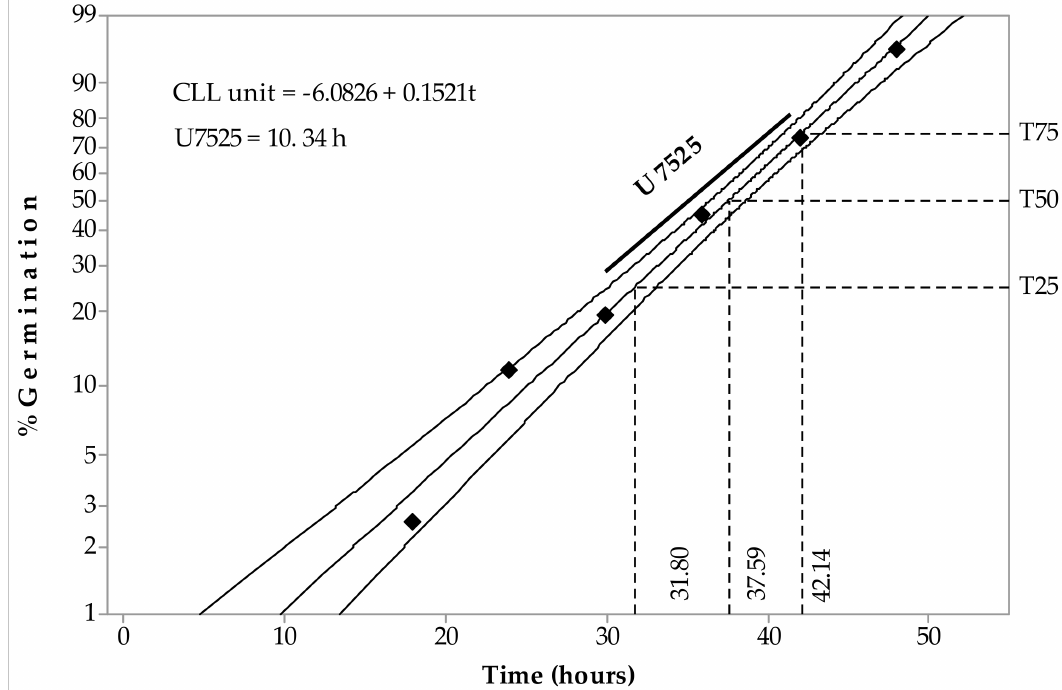
Figure 2. Germination times of BRS 4103 corn cultivar estimated by the Complementary log-log link function. T25 = 31.80 h; T50 = 37.59 h; T75 = 42.14 h and uniformity of germination U7525. At 5% probability.